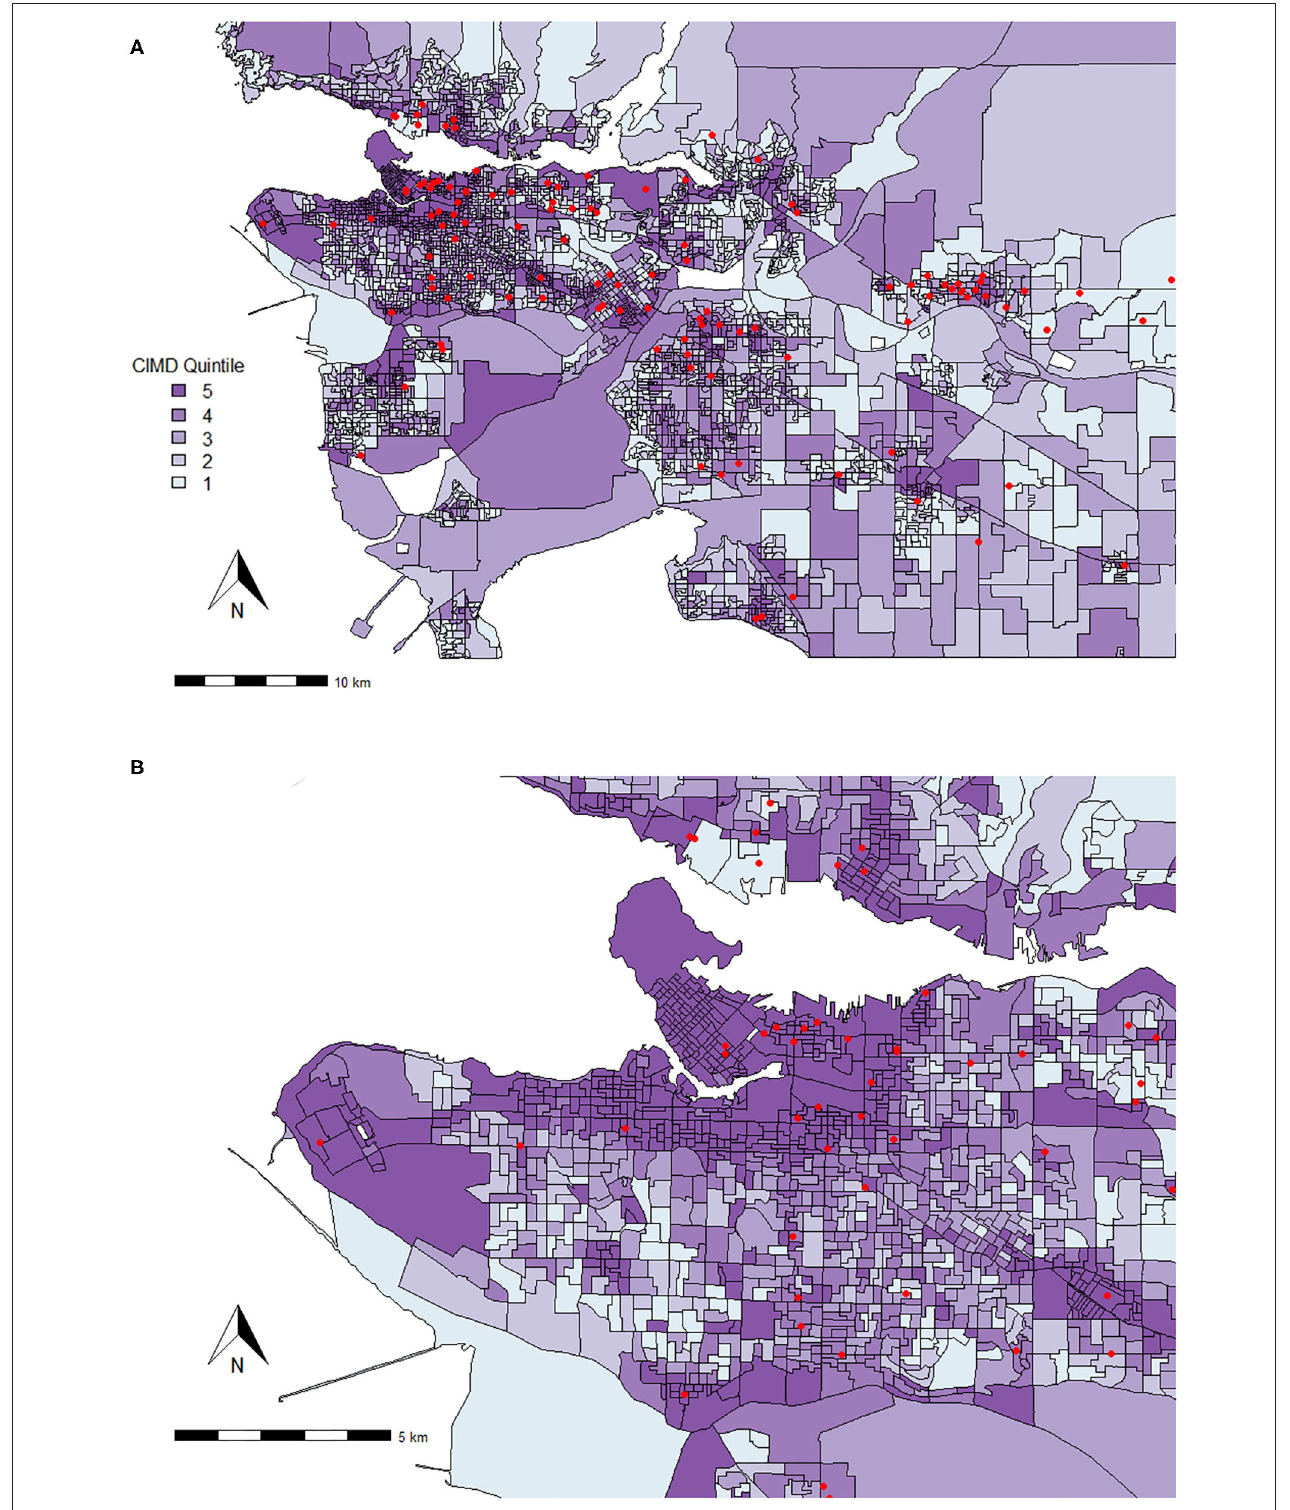
FIGURE 5 | Red dots represent locations where animals scored Unhealthy-Untreatable were surrendered from in (A) Metro Vancouver and (B) the City of Vancouver (September 1, 2016 to August 31, 2020) plotted on top of quintiles for Residential Instability (1 = least instable, 5 = most instable). The Residential Instability factor of the CIMD includes indicators such as the proportion of apartment dwellings; the proportion of persons living alone; the proportion of rented dwellings; and the proportion of population that has moved in the last 5 years. While each point shows the dissemination area of origin, it does not represent the true address.